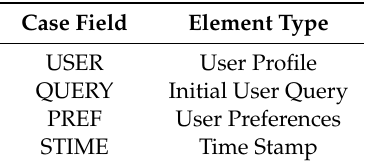
Table 1. Case Attributes